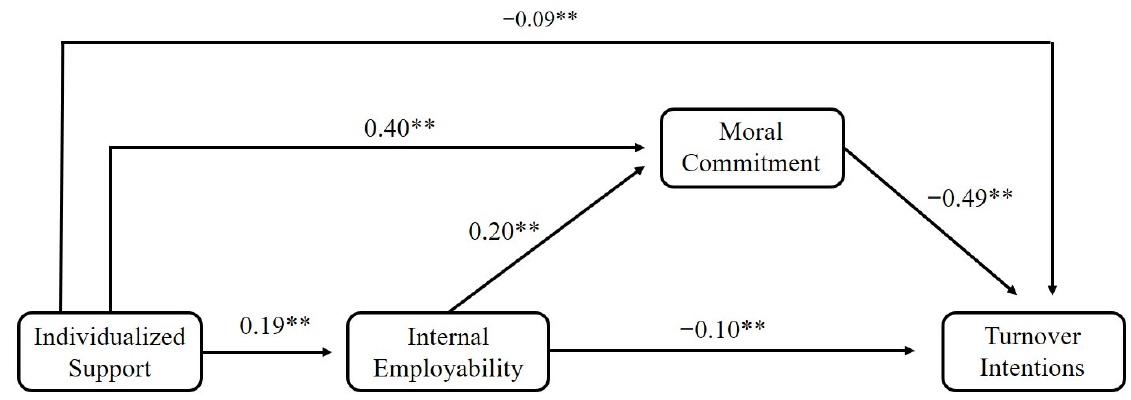
Figure 4. Model 3. Note. ** p < 0.01. Table 7. Indirect effects of model 3.